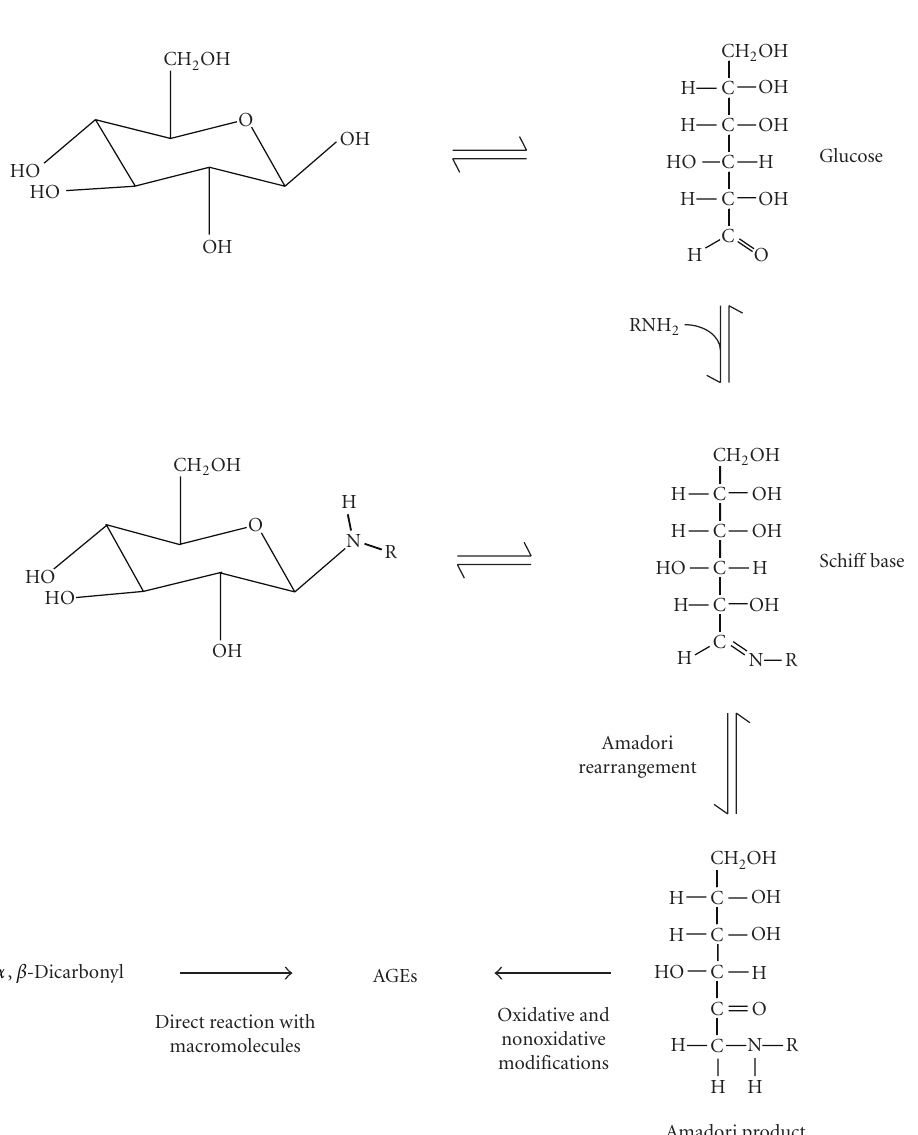
Figure 2: Formation of AGEs in physiological systems. In early glycation, glucose reacts reversibly with amine groups on macromolecules to form a Schi ff base and subsequently an Amadori product. This can undergo further oxidative and nonoxidative modifications to form AGEs. Alternatively, AGEs may also be formed by the direct reaction of reactive α , β -dicarbonyls with